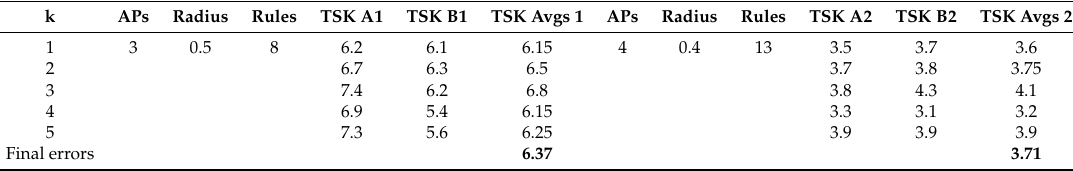
Table 8. Average of the percentage of hypothesis errors from the S1 and S2 datasets.